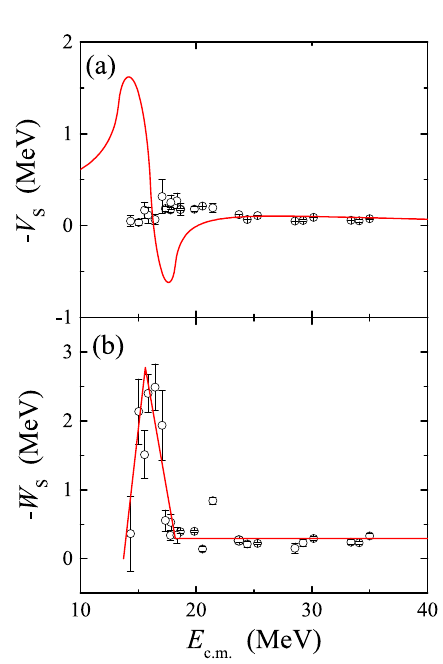
Figure 1. (Color online) Angular distributions of 208 Pb( 7 Li, 6 He) Figure 2. Energy dependence of the depths of real (a) and imagi- reactions for proton transferred to di ff erent states of 209 Bi at nary (b) potentials at the sensitivity radius of 13.5 fm for the 6 He E lab = 21 . 20 (a) and 24.30 (b) MeV, respectively. The experi- + 209 Bi system [11, 13, 14]. Curves in (b) represent the linear mental results are labelled according to the the excitation energy segment fitting for the imaginary potential. The predictions of of 209 Bi. The solid curves represent the CRC fitting results. The the dispersion relation according to the variations of the imagi- elastic scattering of the entrance channel 7 Li + 208 Pb E lab ( 7 Li) = nary potentials are present in (a). 24.30 MeV as well as that of the corresponding exit channel 6 He + 209 Bi at E = 17 . 84 MeV [15] are also shown by the solid cir- lab cles and squares, respectively. The dash-dotted curve is the CRC fitting result and the dashed curve represents the calculation re- sult with the OMP extracted from the transfer reaction.